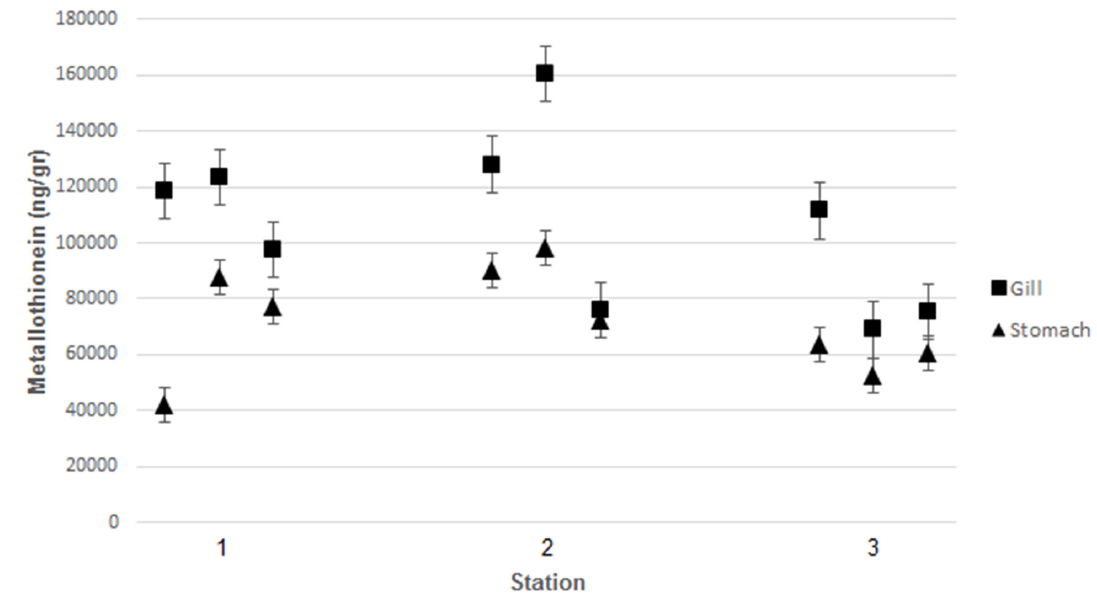
Figure 3. Metallothionein level (wet mass) in the gills and stomach of Crassostrea iredalei collected from the three stations. Station 1, Mayangan; Station 2, Kenjeran; Station 3, Gresik port.